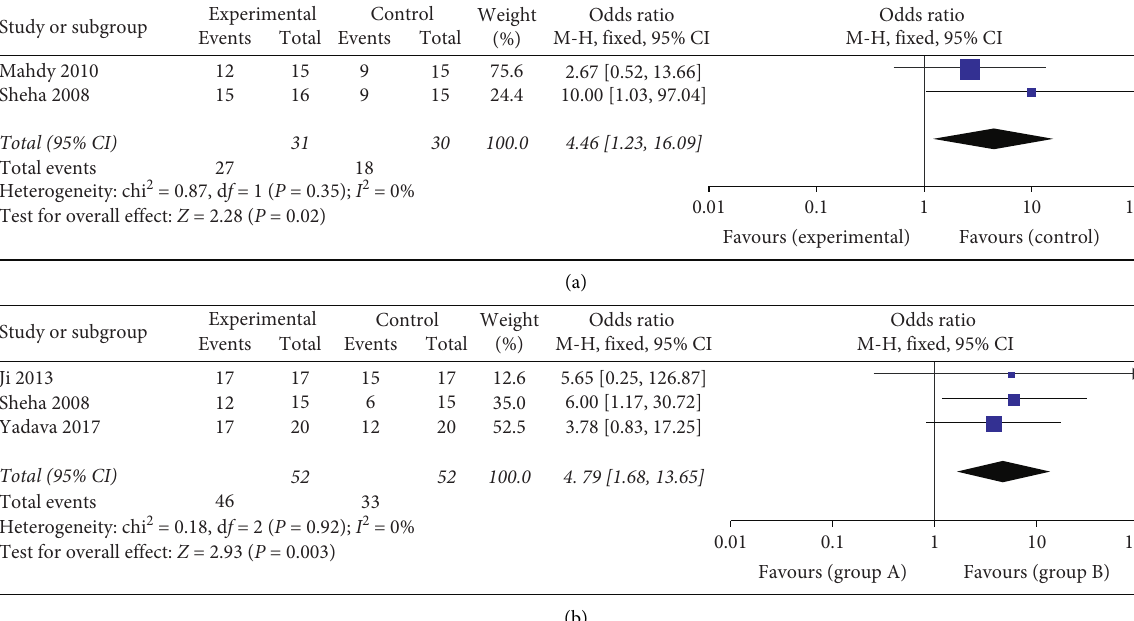
Figure 4: Forest plot comparison of the number of eyes with complete success after treatment in AMTand control group. (a) Six months postoperatively; (b) One year postoperatively.